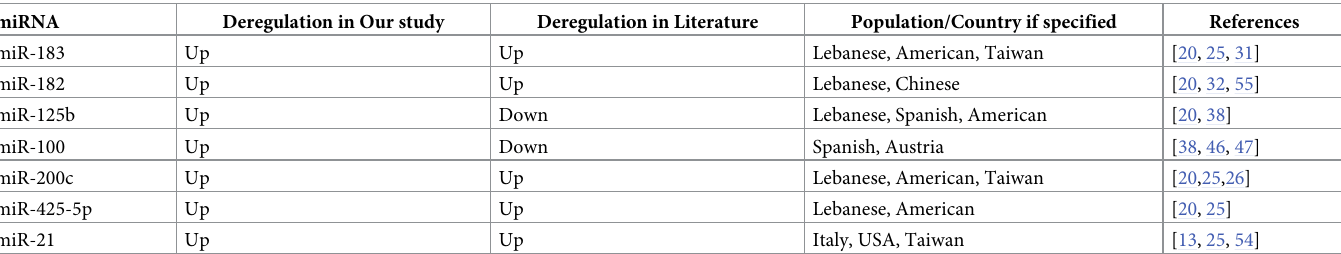
Table 1. Mode of deregulation of the studied miRNA in different studies in comparison to our findings. (Up means upregulated; Down means downregulation). miRNA Deregulation in Our study Deregulation in Literature Population/Country if